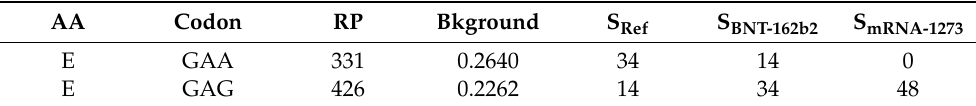
Table 3. Codon optimization of Asp (D) codons in the two vaccine mRNAs. The column headers are identical to those in Table